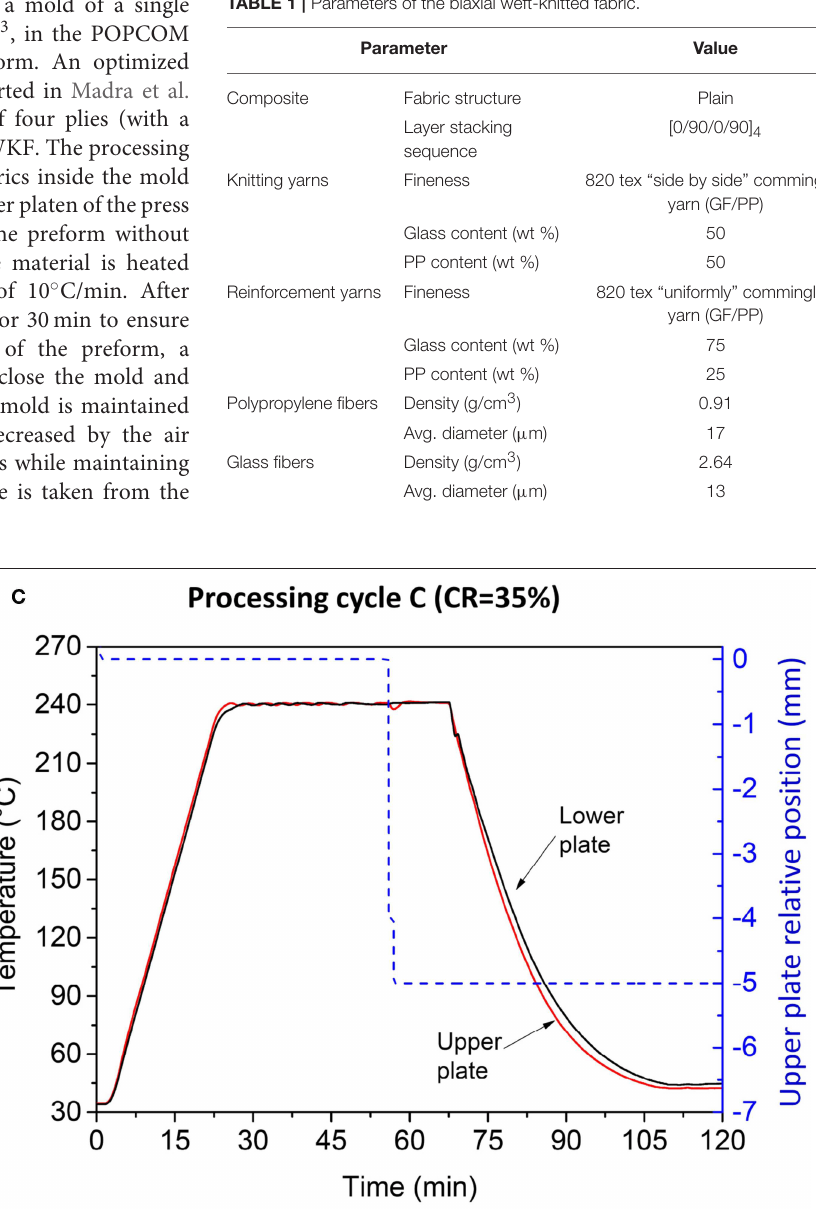
Frontiers in Materials |